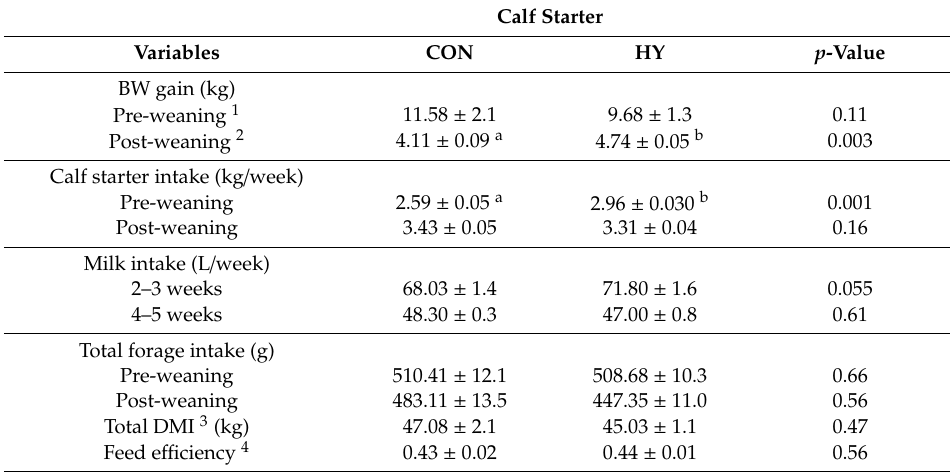
Table 2. Growth performance, feed (calf starter, milk, and forage) intake, total DMI, and feed e ffi ciency of the calves fed the CON and HY calf starters (mean ±